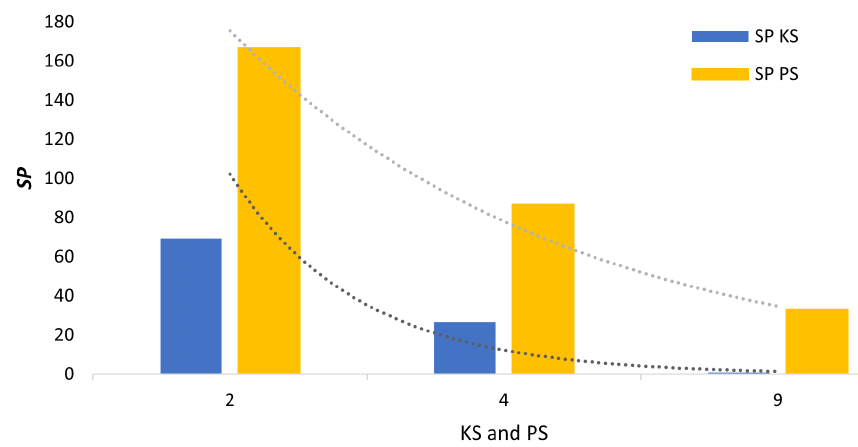
Figure 11. KS and PS signal recognition